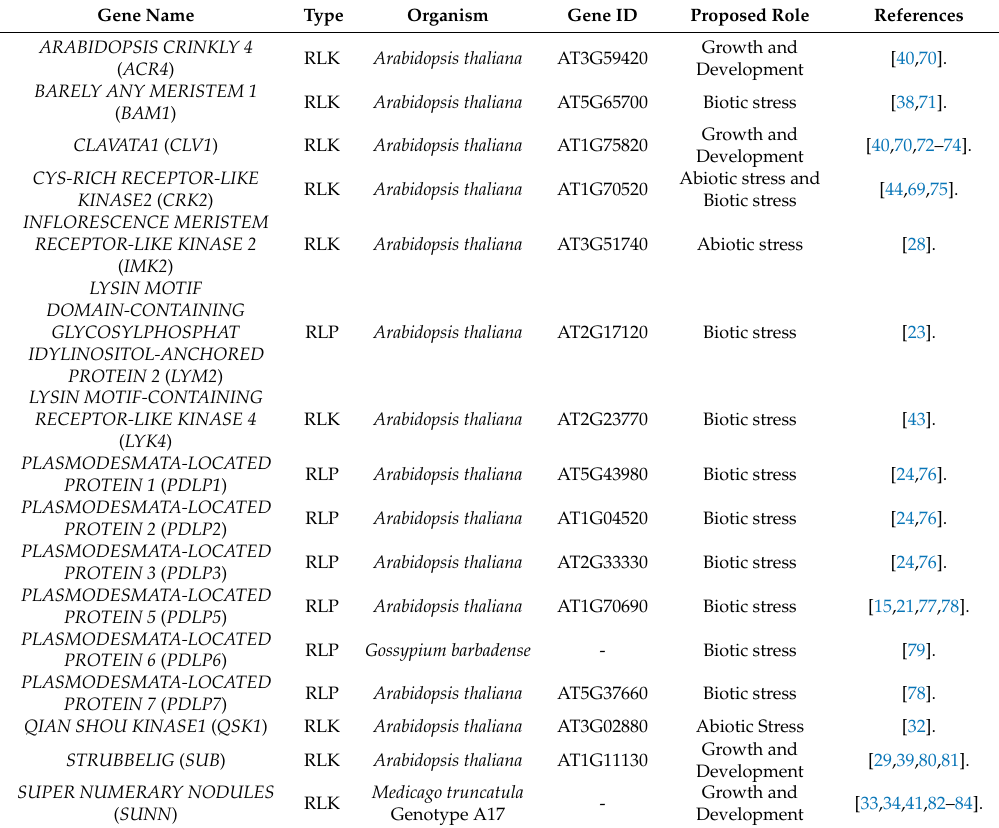
Table 1. Plasmodesmal-receptor like proteins (PD-RLPs) and plasmodesmal-receptor-like kinases (PD-RLKs) involved in plant development and environmental